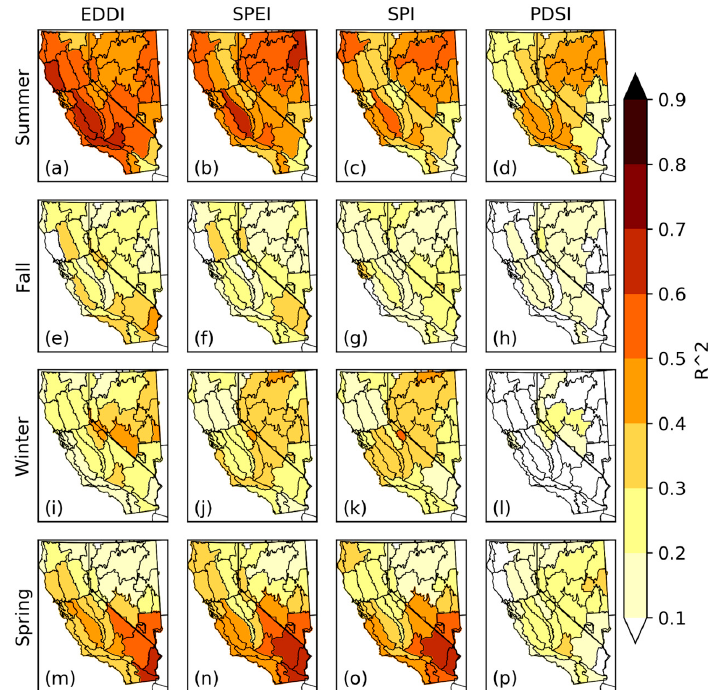
Figure 6. Start of season (90-day lag) R 2 of each drought index with the seasonal 1000-hr fuel moisture fire danger output by season across the period 1979–2015 for each PSA in California and Nevada. Drought indices include ( a , e , i , m ) EDDI, ( b , f , j , n ) SPEI, ( c , g , k , o ) SPI, and ( d , h , l , p ) PDSI and seasons include ( a , b , c , d ) summer, ( e , f , g , h ) fall, ( i , j , k , l ) winter, and ( m , n , o , p )